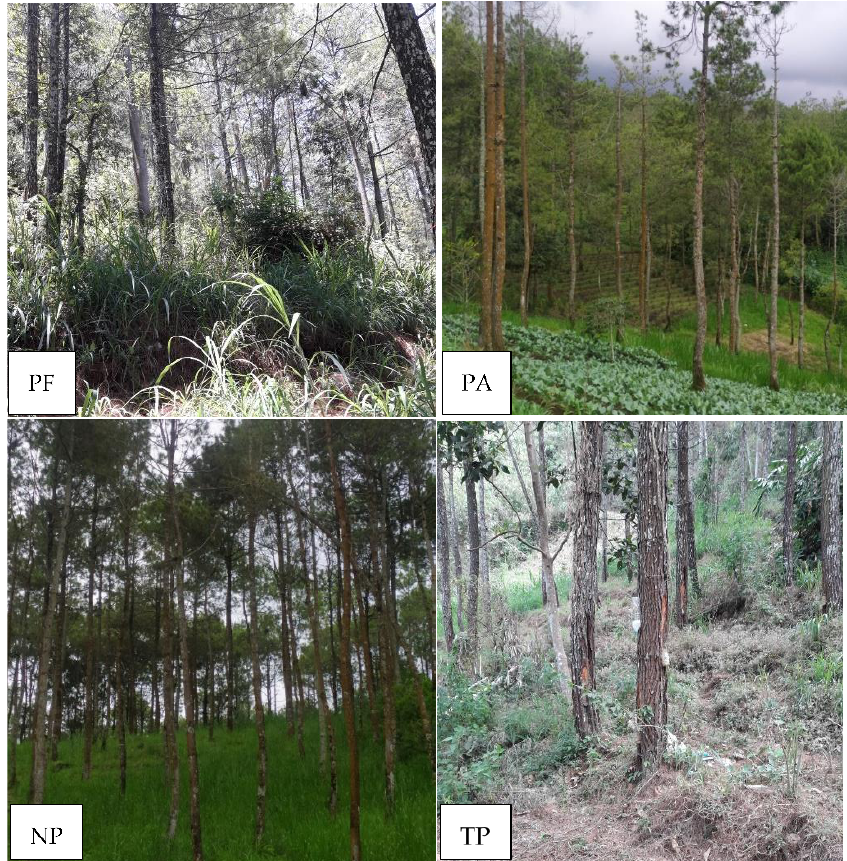
Figure 2. Views of the pine forests. The protected pine forest (PF) in Mojokerto District, the pine forest-based agroforestry (PA) in Batu City, the non-tapped pine forest (NP) in Batu City and the tapped-pine forest (TP) in Batu City. Table 1. Characteristics of the studied pine forests in East Java,